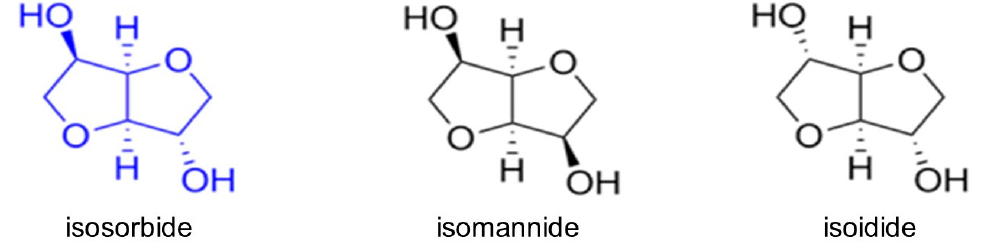
Figure 1. Molecular structures of isosorbide, isomannide, and isoidide.